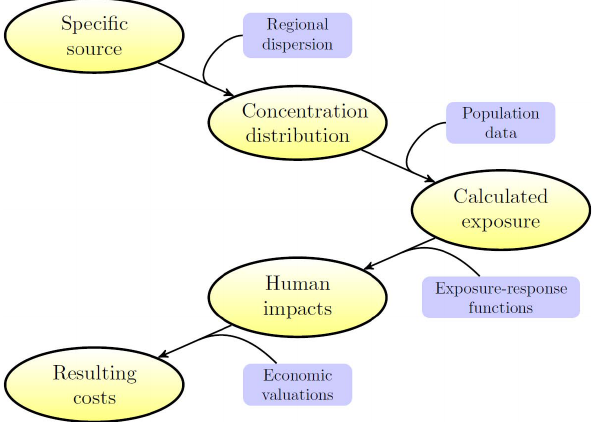
Fig. 1. A schematic diagram of the impact-pathway methodology. The site-specific emissions result (via atmospheric transport and chemistry) in a concentration distribution, which together with de- tailed population data, can be used to estimate the population-level exposure. Using exposure-response functions and economic valu- ations, the exposure can be transformed into impacts on human health and related external costs.